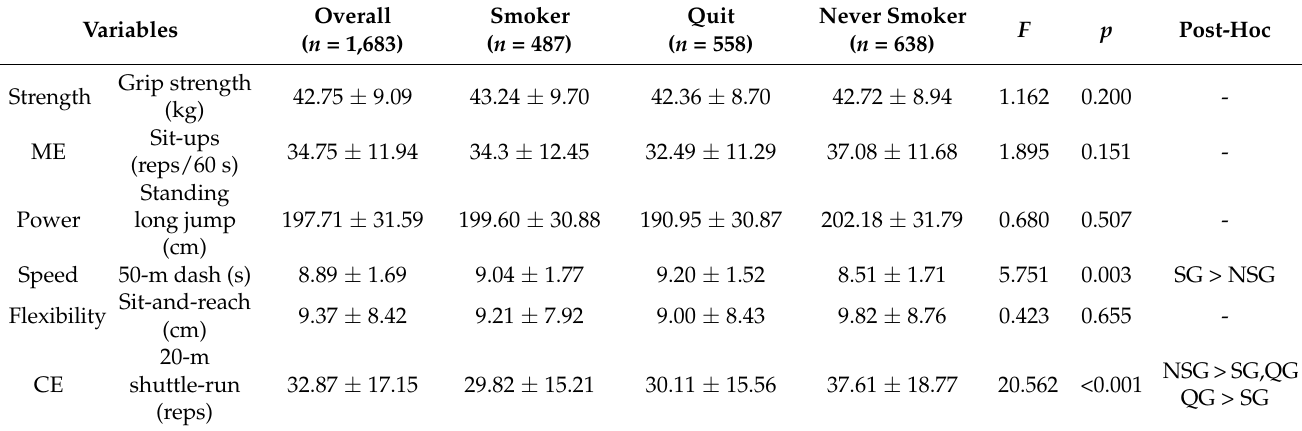
Table 2. Differences in physical fitness variables based on smoking in non-elderly adult